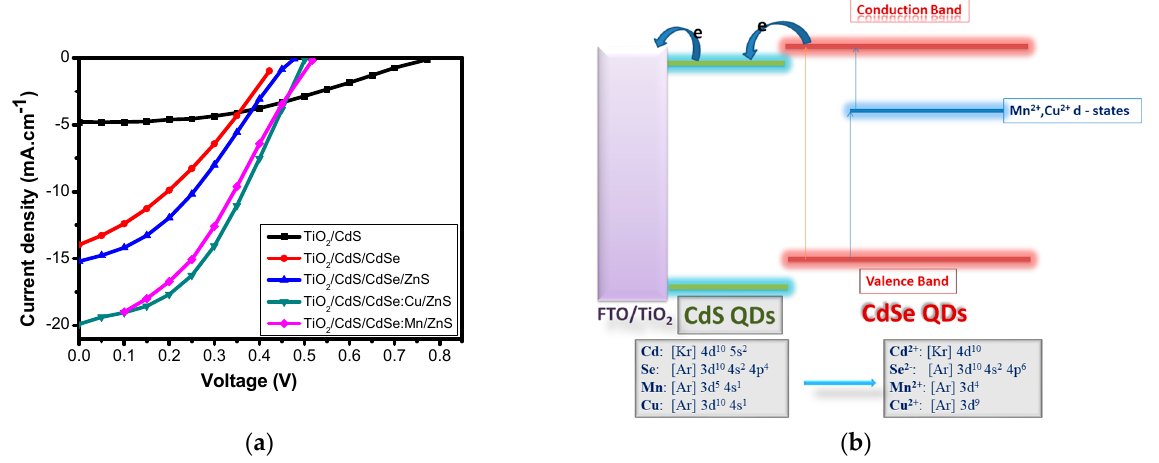
Figure 7. ( a ) Current density–voltage (J–V) curves of QDSSCs with different photoanodes and ( b ) schematic diagram of the energy level of a photoanode with CdSe QDs doped Mn or Cu from Phuc, D.H and co-works, 2019 [120].